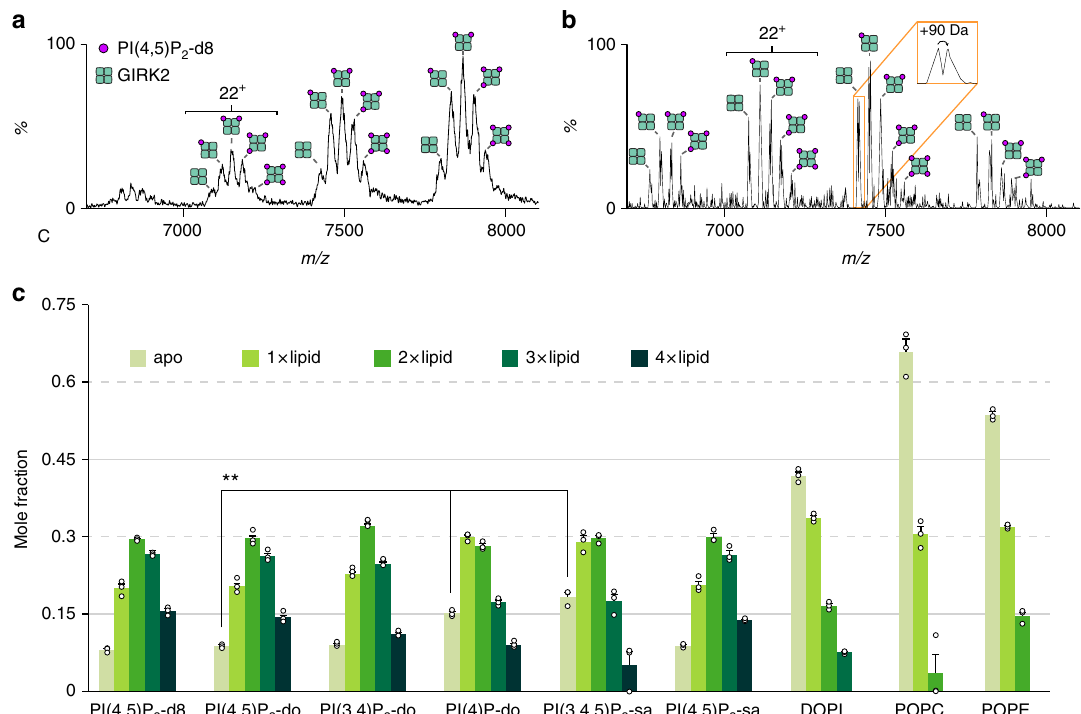
Fig. 3 Selective binding of PIPs and phospholipids to GIRK2. Representative mass spectra of a mixture of 0.5 µ M GIRK2 and 3 µ M PI(4,5)P 2 -d8 acquired on the a Synapt G1 and b Exactive Plus EMR. Up to four lipid binding events are observed in the mass spectra, and higher resolution achieved by the EMR enabling small molecule adducts to be resolved. c Plot of mole fraction data obtained from deconvoluting mass spectra for various lipids mixed with GIRK2 at a molar ratio of 6:1, respectively. GIRK2 has much higher af fi nity for PIPs over other phospholipids. Reported is the average and s.e.m. ( n = 3). Student ’ s t test (two-tailed) was used for statistical analysis ( ** P < 0.01) with the apo molar fraction being used for comparison. Lipid abbreviations are provided in Supplementary Table 3. Source data are provided as a Source Data fi